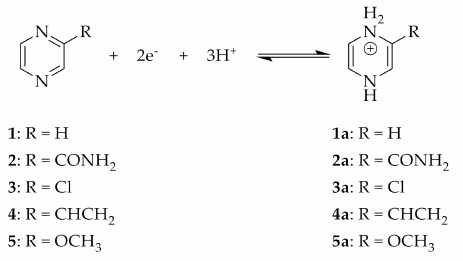
Figure 1. Chemical structures of the different pyrazines studied by Swartz and Anson [16] and the general reduction